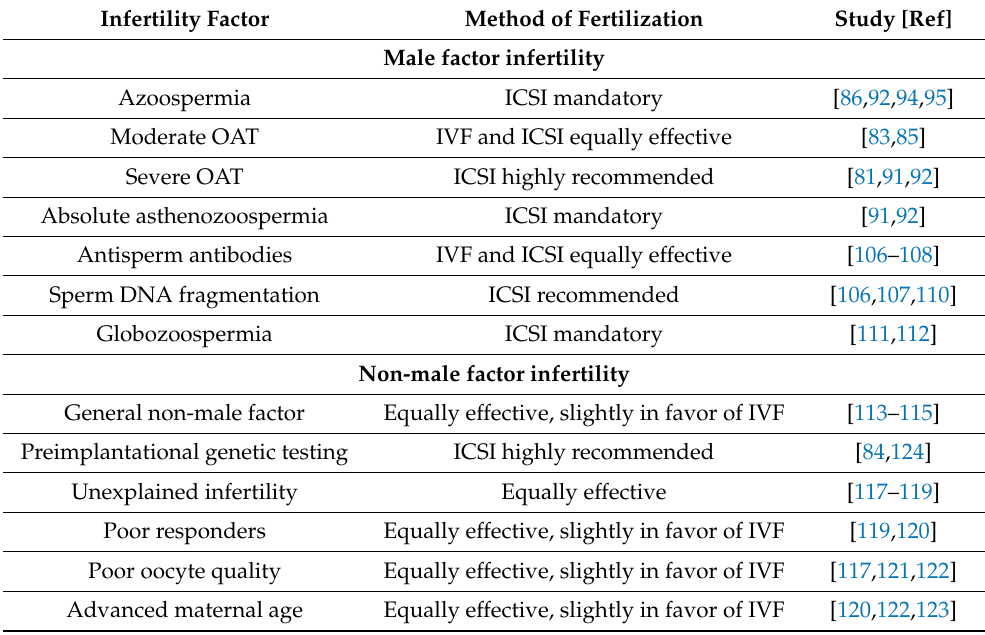
Table 2. ICSI or IVF as fertilization methods applied in male and non-male factors infertility. ICSI: intracytoplasmic sperm injection; IVF: in vitro fertilization; OAT: oligoasthenoteratozoospermia. Adapted with permission from Ref